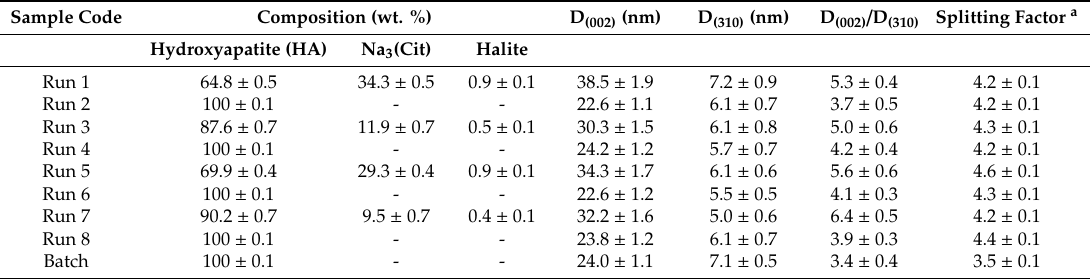
Table 2. Composition and crystallographic parameters of CaP NPs